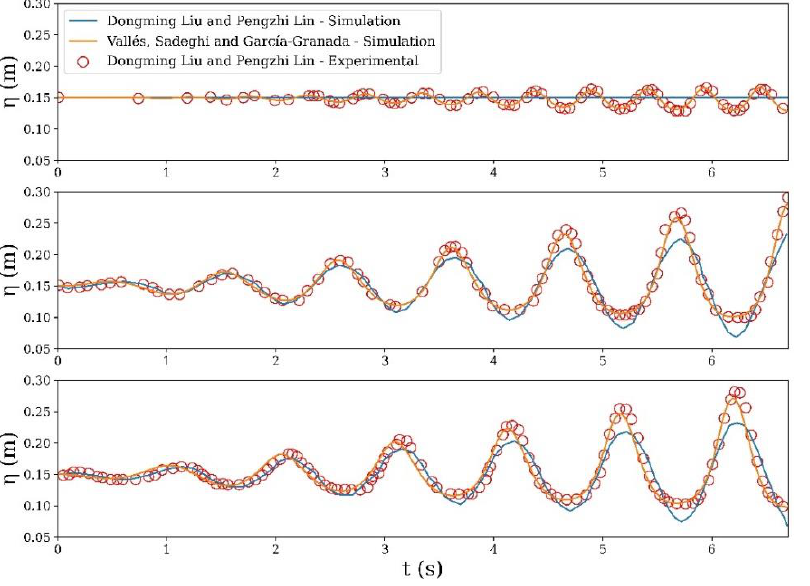
Figure 3. Comparison of the time series of the free surface elevation h at probe 1, probe 2, and probe 3, respectively.